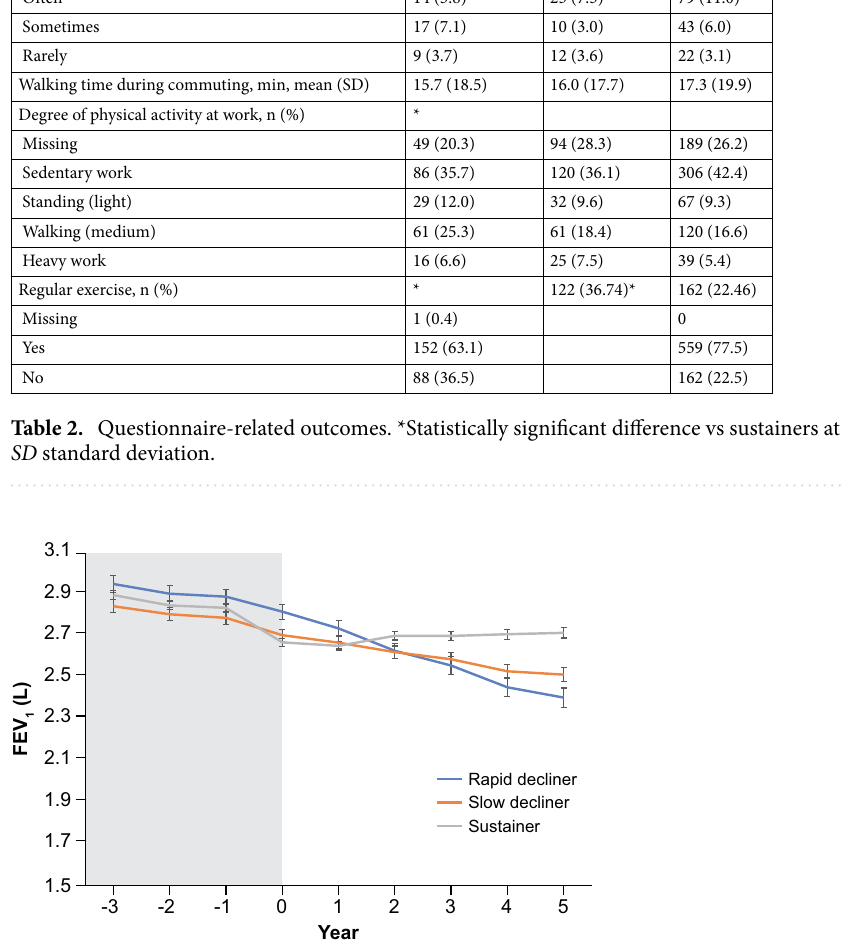
plementary Fig. S1 including the top 30 factors) and those based on answers to questionnaires (see Supple- mentary Fig. S2). Mean FVC decline has been presented in Supplementary Fig. S3. The results of the logistic regression model indicated that vital capacity, mean corpuscular hemoglobin, smoking status, cough, platelet count, total protein, HbA1c, FEV 1 % (see Supplementary Fig. S4), and uric acid were predictive of rapid declin- ers. In contrast, arrhythmia, other diseases, FEV 1 , mean corpuscular volume, BMI, mean corpuscular hemo- globin concentration, albumin, C reactive protein, smoking duration, hematocrit, aspartate aminotransferase, percentage VC, and duration of smoking cessation were unlikely to predict rapid decliners (see Supplementary Table 2). Generally consistent with these results were those obtained using a logistic regression model, including questionnaire-obtained data comprising lifestyle, symptoms, and treatment-related information (see Supple- mentary Table 3).